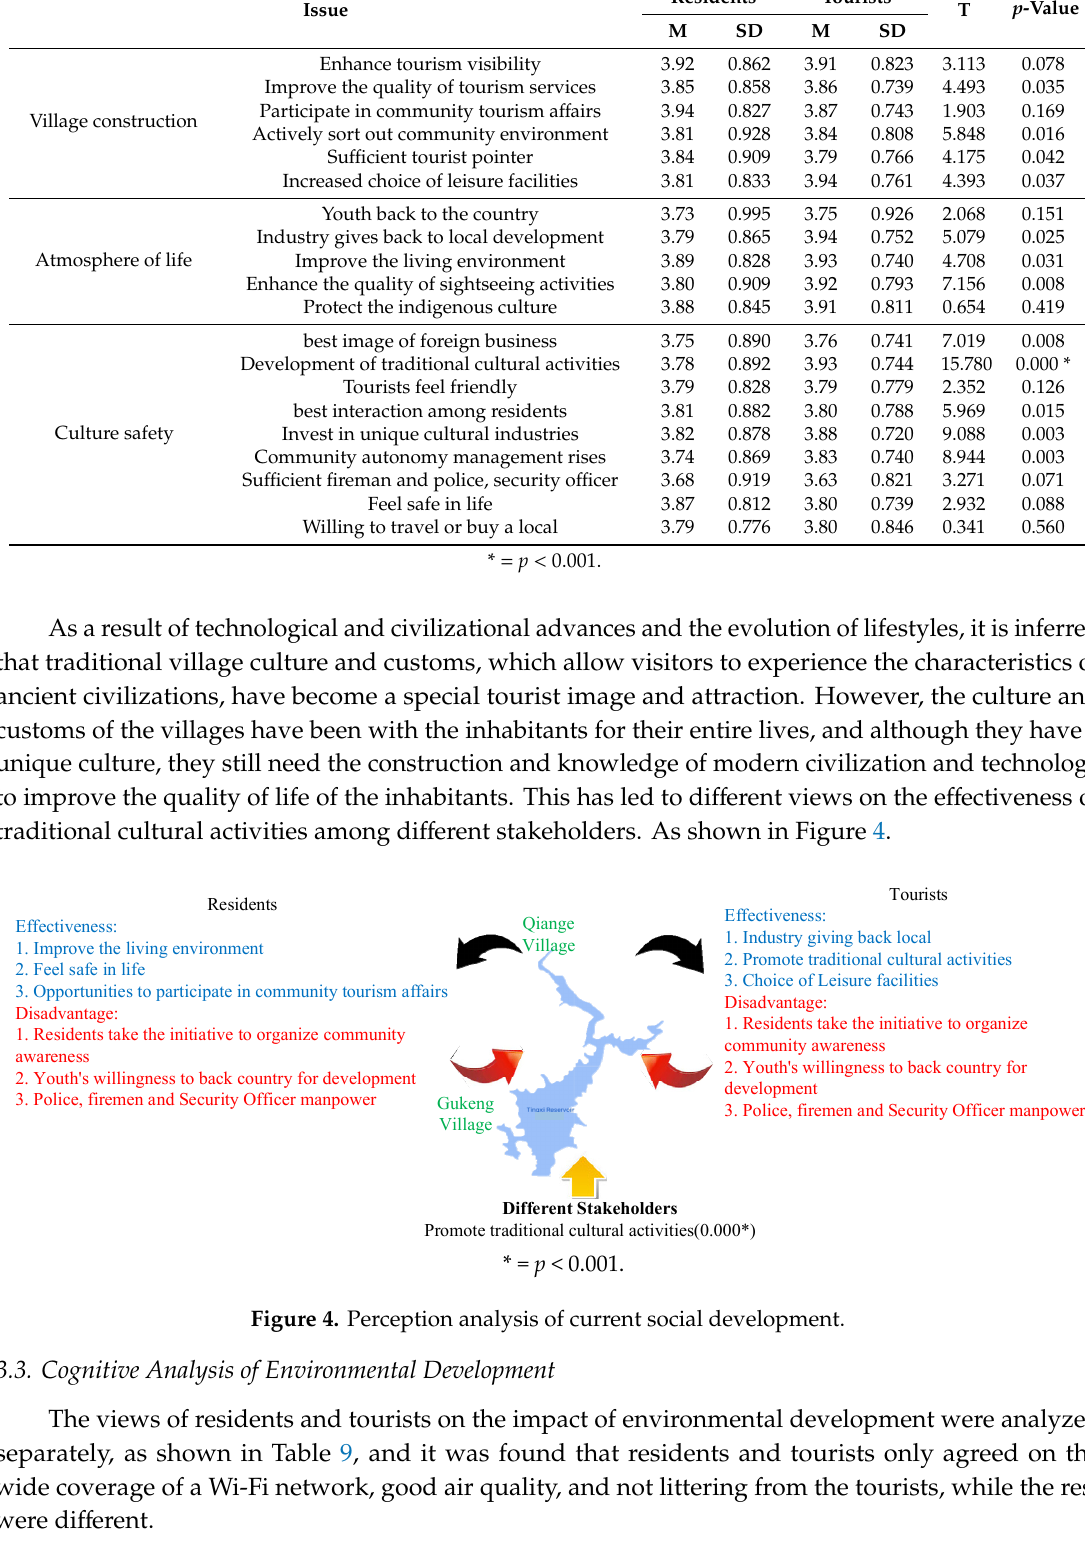
Table 9. Perception of the current state of environmental development by residents and visitors.